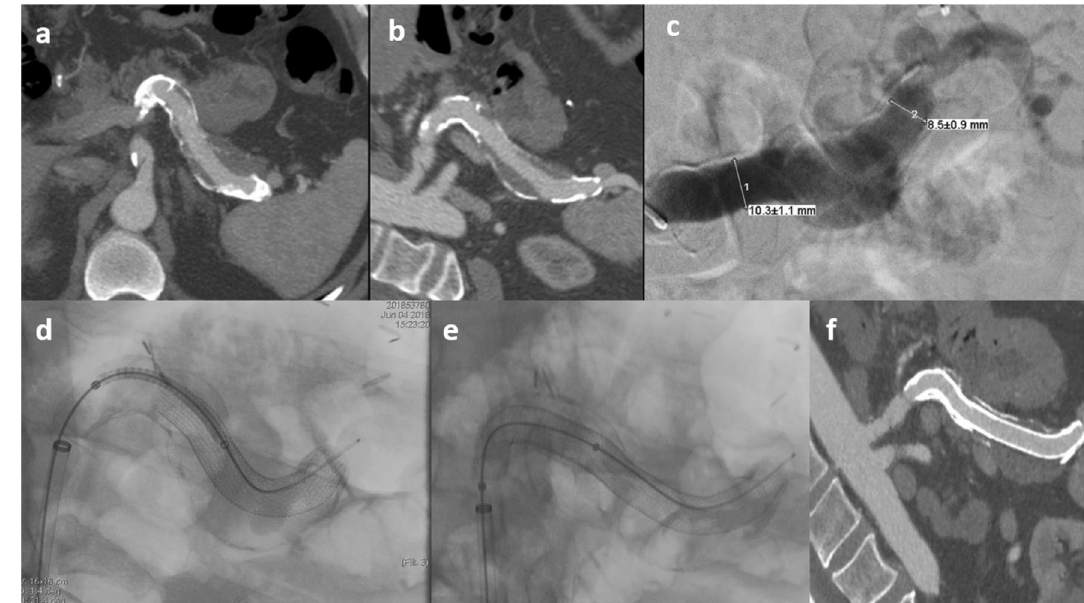
Figure 2. ( a ) CT scan in arterial phase demonstrated a 95 × 36 mm GAA of the splenic artery. ( b ) Curved reconstruction shows the complete extension of the aneurysm and the thrombosed part of the sack. ( c ) Angiogram confirming the aneurismal dilatation and allowing treatment planning. ( d , e ) Endovascular treatment was performed by positioning three overlapping covered stents (Viabahn; Gore, Falstaff, AZ) measuring in order from distal to proximal: 10 × 100 mm, 10 × 50 mm and 11 × 50 mm f) Angio-CT with curved reconstruction shows patency of the splenic artery with aneurysm complete